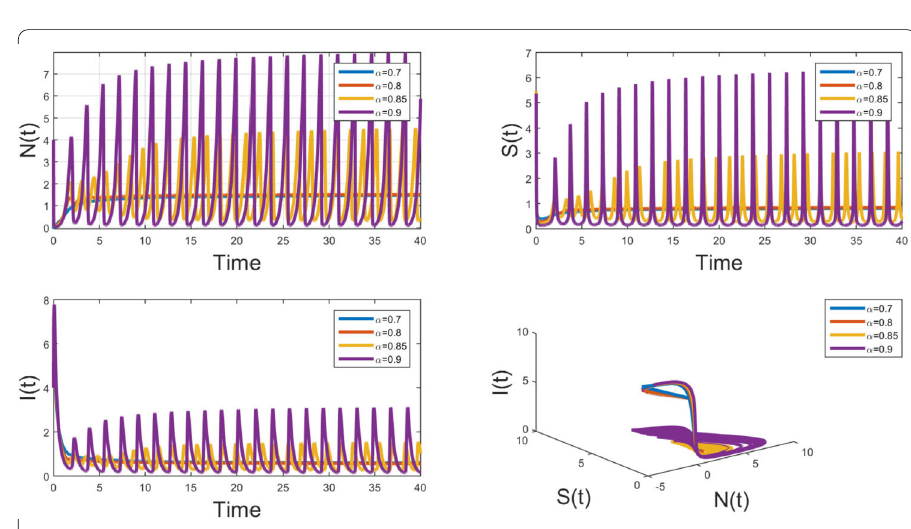
Figure 11 Influence of the memory rate on the stability of the